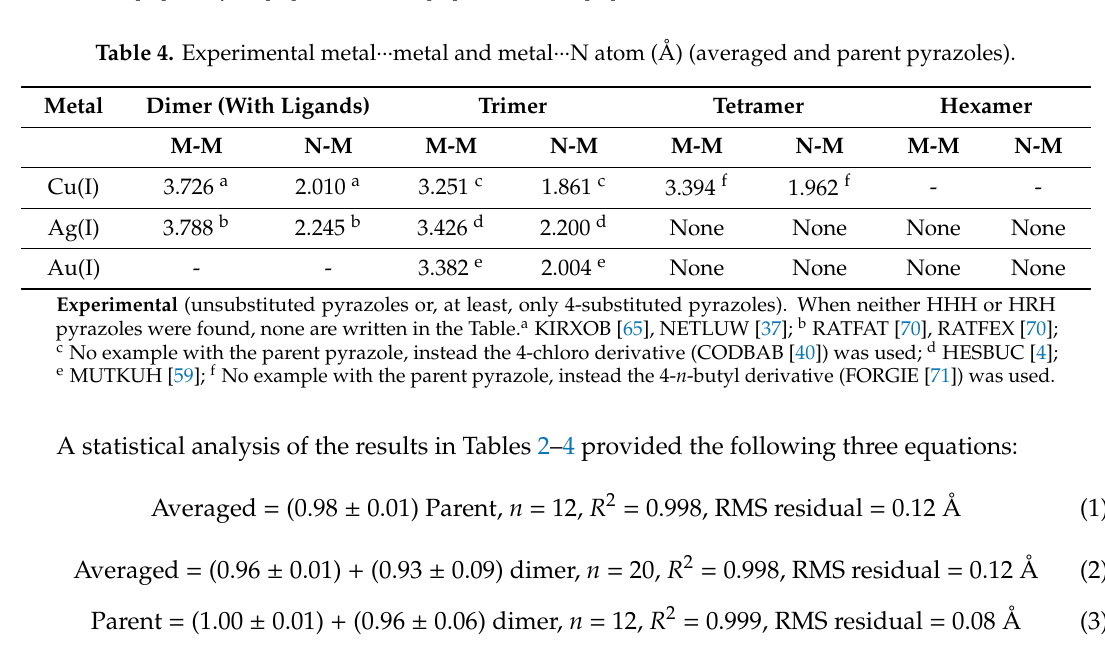
Table. a BITSAB [63], IPIGET [35], JEMCAF [32], NETMAD [37]; b FINWIL [64], KIRXIV [65], ZIGROZ [66], ZIGRUF [67]; c BELTOC [42], CODBAB [40], VIJMUW [41], XELXAN [43]; d AWAWUS [67], CENFIM [68],